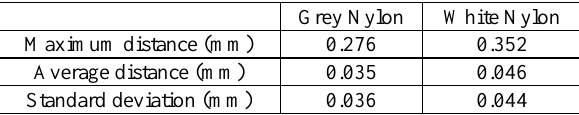
Table 1: Statistical indices obtained from the comparisons of